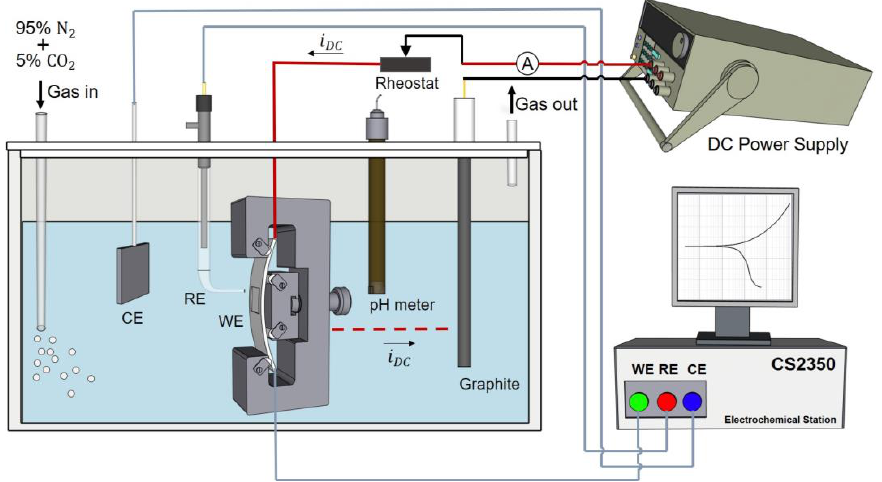
Figure 3. Schematic diagram of the experimental set-up for electrochemical measurements.